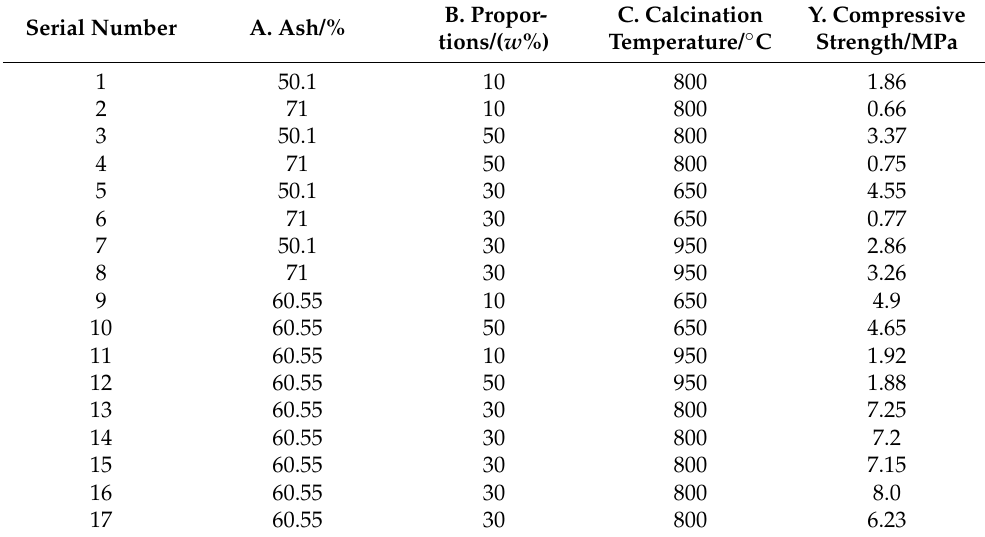
Table 4. Response surface test results.